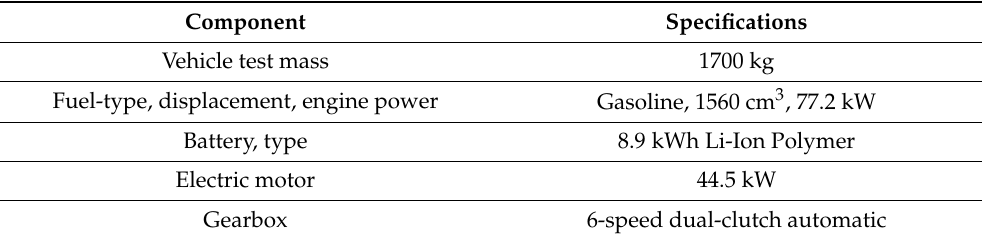
Table 1. Parallel P2 PHEV Technical Specifications.